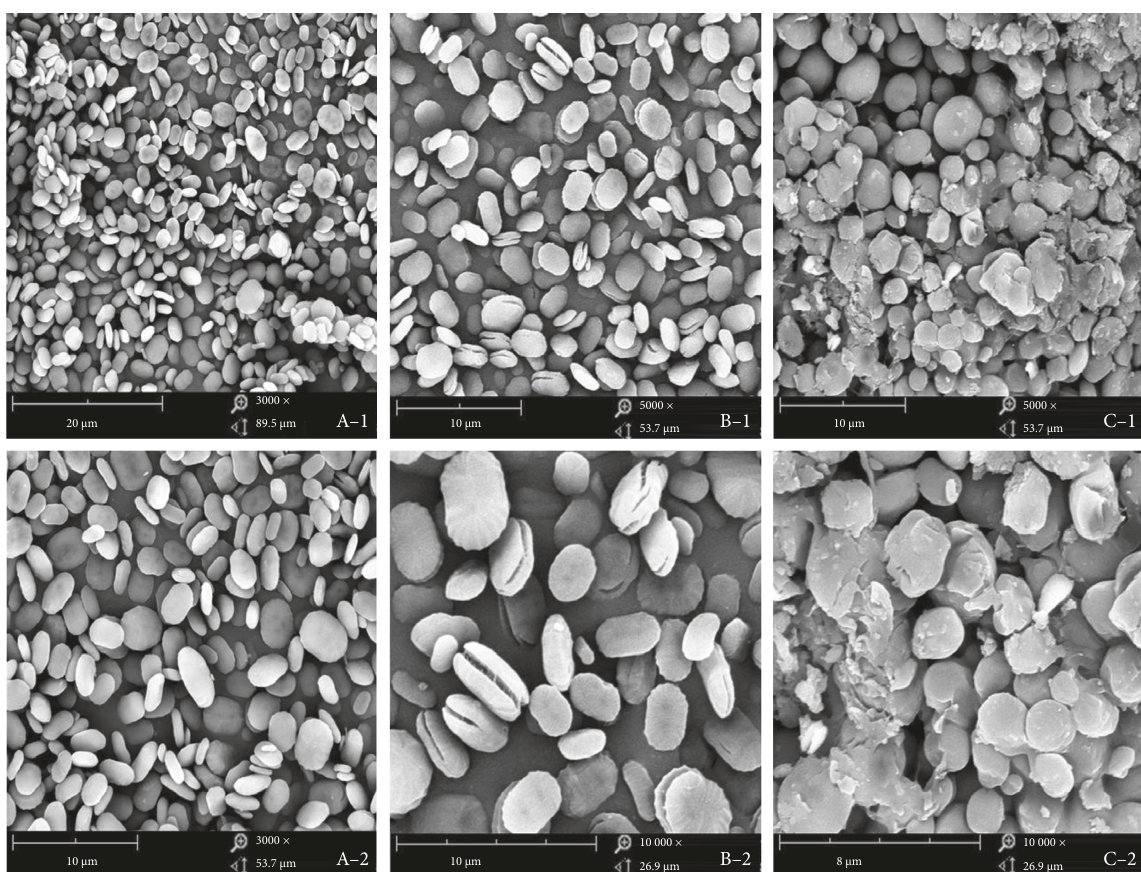
Figure 2: SEM images of samples. (A-1, A-2) EGP, (B-1, B-2) H-EGP, and (C-1, C-2) C-EGP.